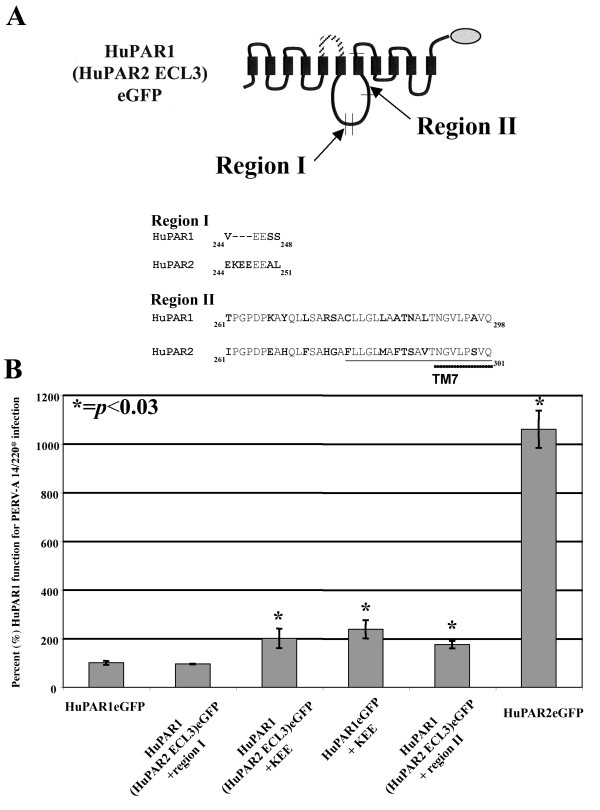
Mapping the contribution of the third intracellular loop of HuPAR2 for PERV-A infection. The third intracellular loop (ICL3) contains eighteen single amino acid differences, between HuPAR1 and HuPAR2, and a three amino acid insertion in HuPAR2. In order to determine what sequences in HuPAR2 ICL3 are required in addition to the third extracellular loop (ECL3) of HuPAR2, two HuPAR2 regions, I and II, were swapped. (A) shows the location of Regions I and II and the respective sequence differences (in bold) between HuPAR1 and HuPAR2. (B) shows chimera function for PERV-A 14/220* infection. Region II in the HuPAR1(HuPAR2 ECL3)eGFP backbone results in a statistically significant (p ≤ 0.03) increase, though neither Region confers full HuPAR2 function.